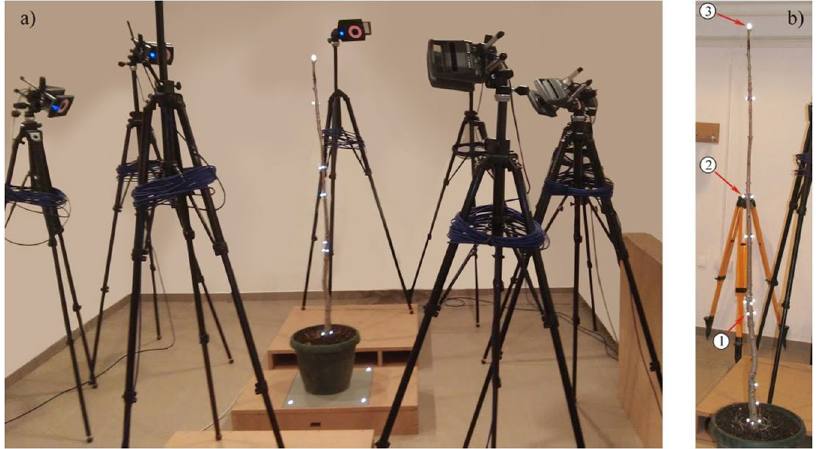
Figure 1. ( a ) The Vicon 3D motion capture system; ( b ) A tree under considerations with several markers along it and three markers numbered (1, 2 and